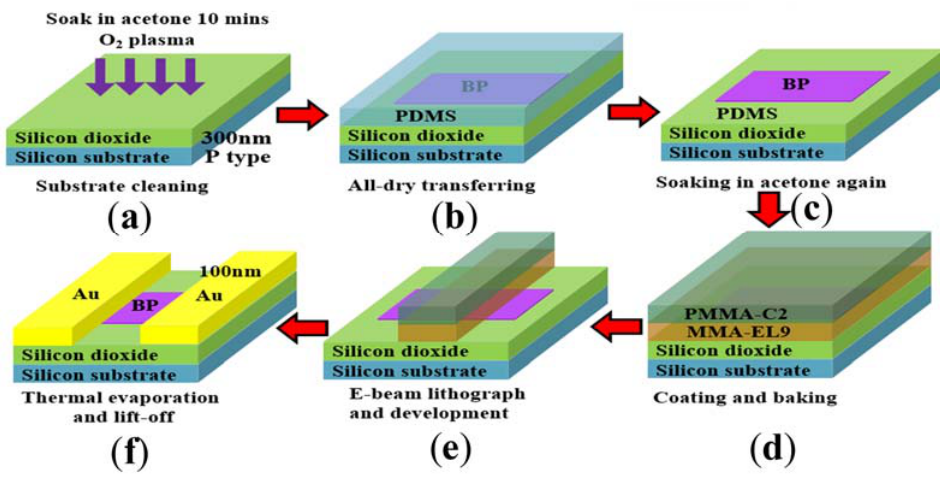
Figure 1. Schematic illustration of fabrication procedures of multilayer BP FETs. ( a ) Substrate cleaning by soaking in acetone and O 2 plasma; ( b ) All ‐ dry transferring; ( c ) Sample cleaning by soaking in acetone again; ( d ) Coating and baking e ‐ beam lithography resist; ( e ) E ‐ beam lithography and development; ( f ) Thermal evaporation and lift ‐ off process.